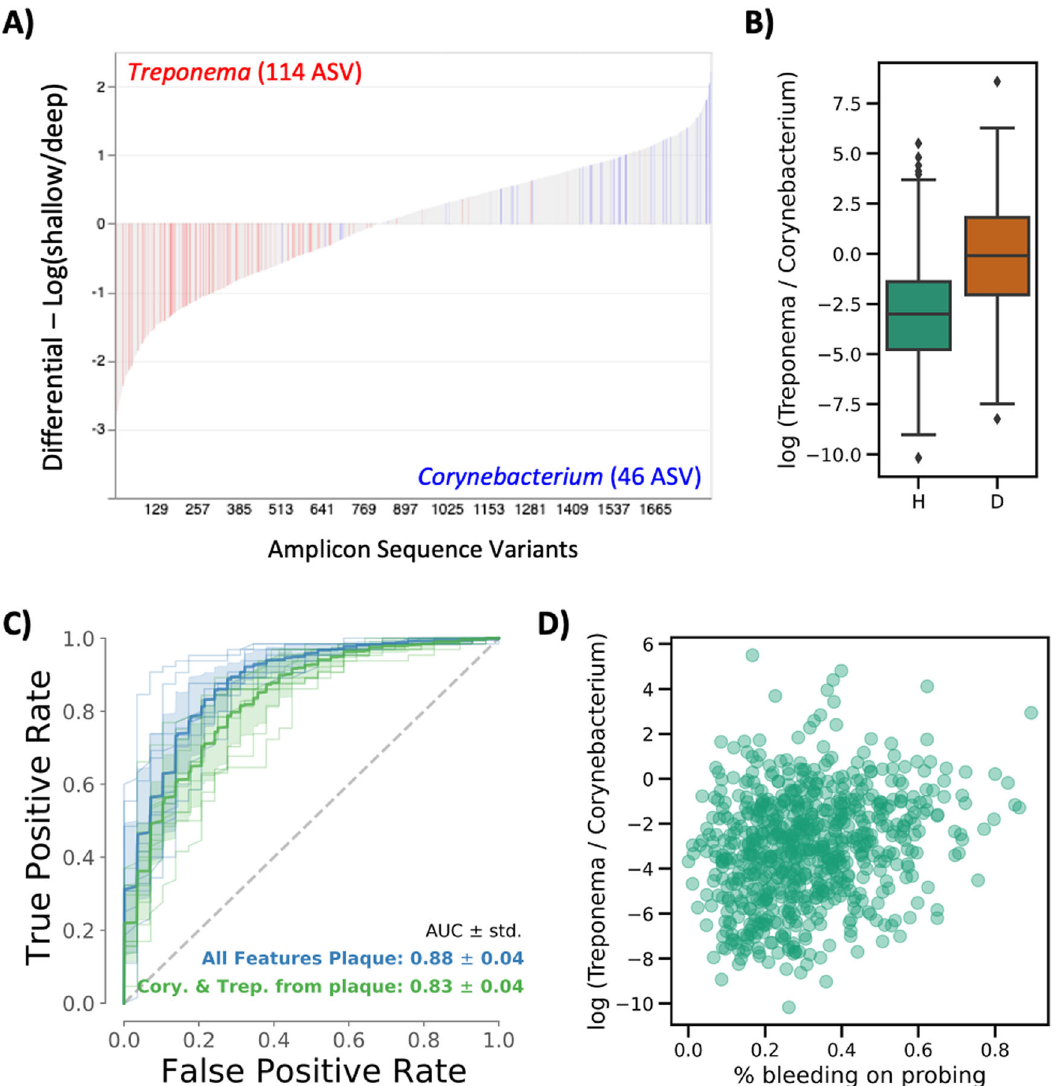
Fig. 3 The ratio of Treponema: Corynebacterium is an early microbial indicator of periodontal disease (MIP) in subgingival plaque. A Differential ranking with Songbird revealed that Treponema sequences in subgingival plaque were associated with deep periodontal pockets, whereas Corynebacterium sequences were associated with shallow periodontal pockets. B The log-ratio of Treponema : Corynebacterium signi fi cantly distinguishes shallow (H = healthy sites) from deep (D = diseased sites) periodontal pockets and is used as a Microbial Indicator of Periodontal Disease (MIP). The box shows the quartiles of the dataset while the whiskers extend to show the rest of the distribution, except for points that are determined to be “ outliers ” using a method that is a function of the inter-quartile range. C ROC curve displaying the accuracy of a Random Forest classi fi er trained on the full dataset (blue) versus trained only on Treponema and Corynebacterium sequences and log-ratio (green) shows similar accuracy at predicting shallow versus deep periodontal pocket depth. D In plaque collected from shallow (healthy) subgingival pockets ( n = 779), MIP was positively correlated with the percent of sites bleeding on probing (Pearson correlation = 0.243, p-value = 8.06e − 12 ), indicating that microbial changes occur in plaque before clinically meaningful